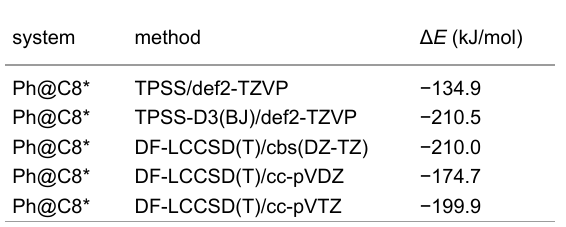
Table 1: Electronic association energy Δ E for Ph@C8*.